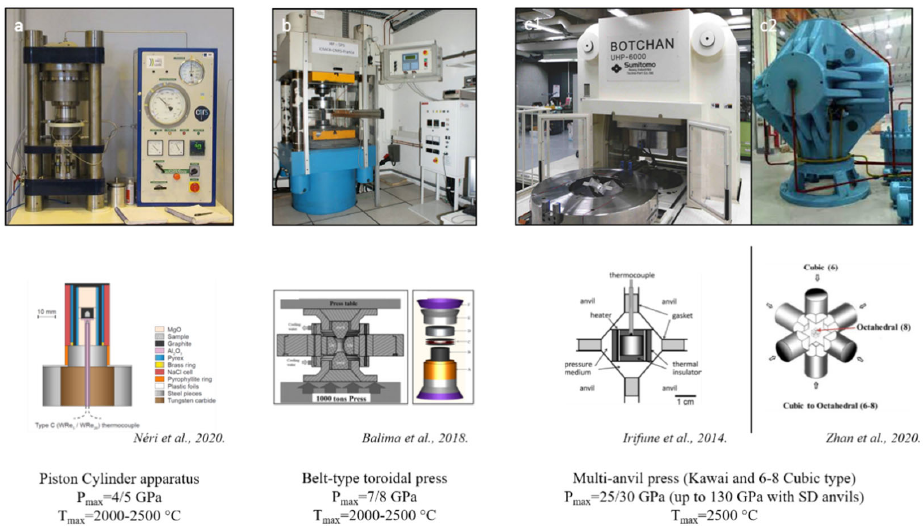
Figure 7. High-pressure devices commonly used for diamond synthesis under high-pressure–high-temperature (HPHT) conditions. From left to right, the maximum pressure achievable increases from 4–5 GPa in Piston cylinder ( a ) to 25–30 GPa in conventional multi-anvil press ( c1 , c2 ). In between ( b ), “belt”-type toroidal press is the most common apparatus used by industrial manufacturer. ( a ) Personal picture, assembly adapted from [100]; ( b ) personal picture, assembly adapted from [101]; ( c1 ) picture from http://www.grc.ehime-u.ac.jp/legacy/news79.html (accessed on 1 December 2021), assembly adapted from [102]; and ( c2 ) adapted from [103]. ( a , b ) are suitable for catalyst-diamond synthesis, whereas ( c1 ) and ( c2 ) have been developed more recently for the synthesis and sintering of large volume of binderless diamonds. (See Section 5 for more details).